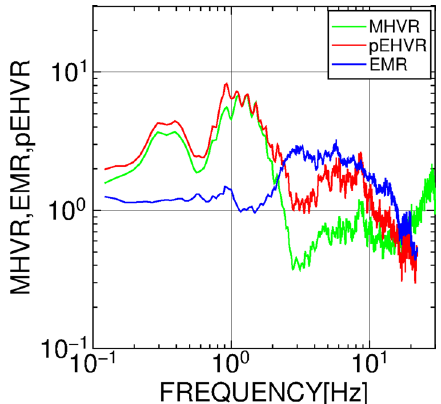
Fig. 2 Observed MHVR and converted pEHVR at the target site KUMA, together with the interpolated EMR for Category-2 used for